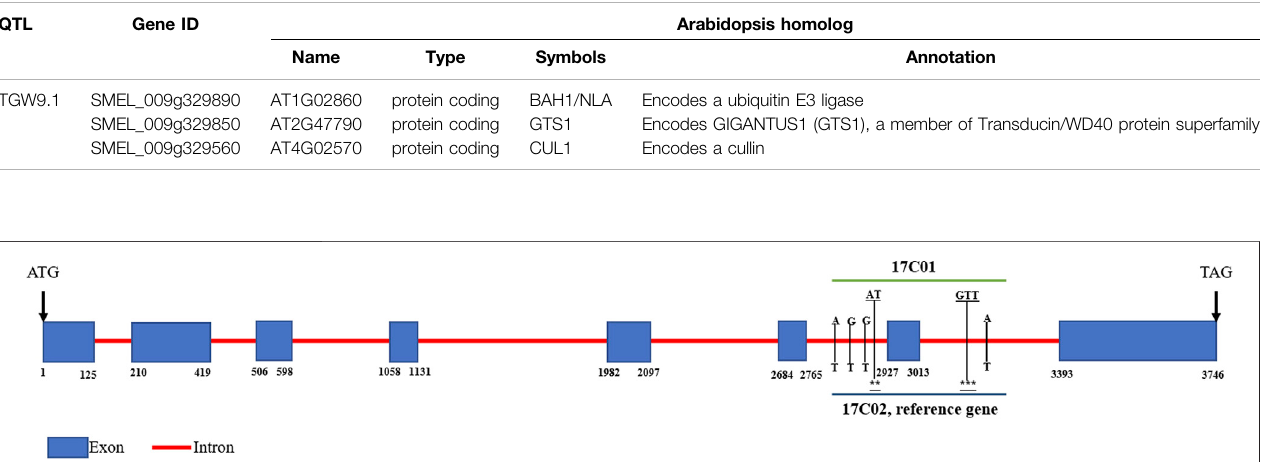
TABLE 3 | The candidate genes of the TGW of eggplant.